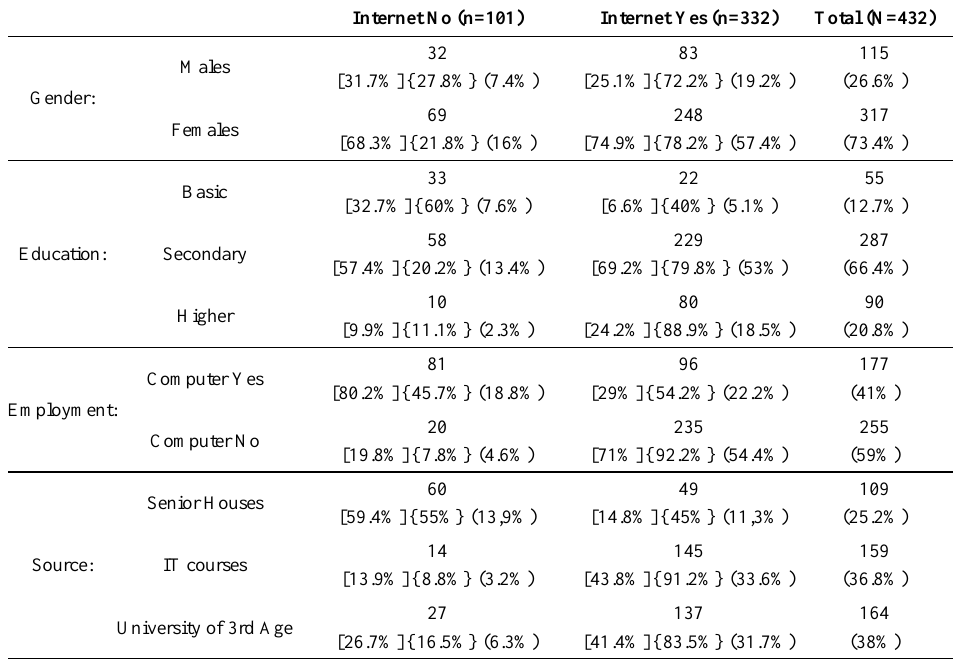
Table 1. Contingency tables for the variable Internet, with the variables Gender, Education, Employment and Source.